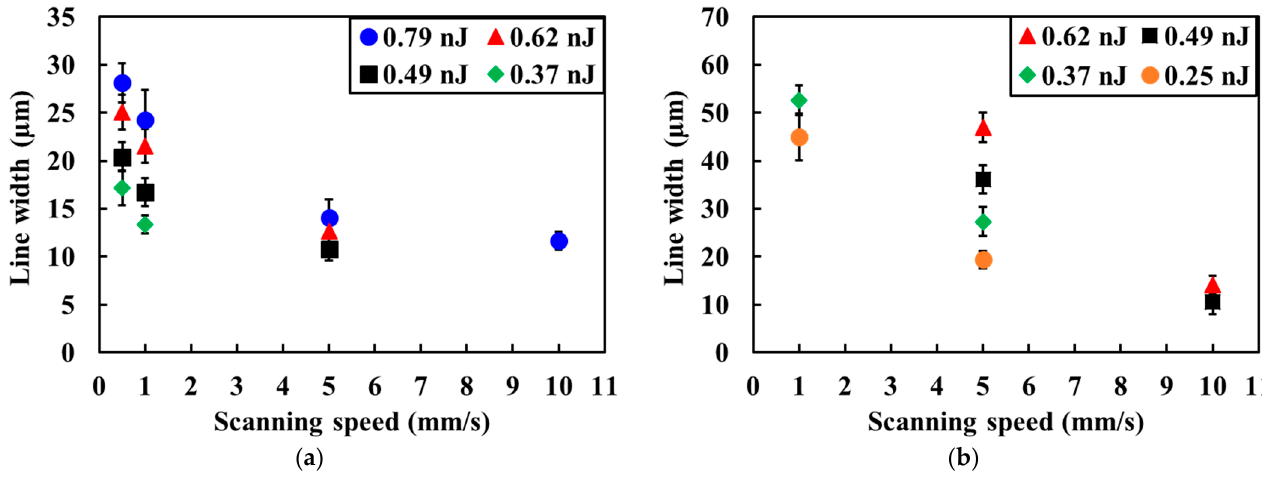
Figure 4. Dependence of scanning speed on line width of the patterns formed at various pulse energies for ( a ) glass substrates and ( b ) PDMS substrates.